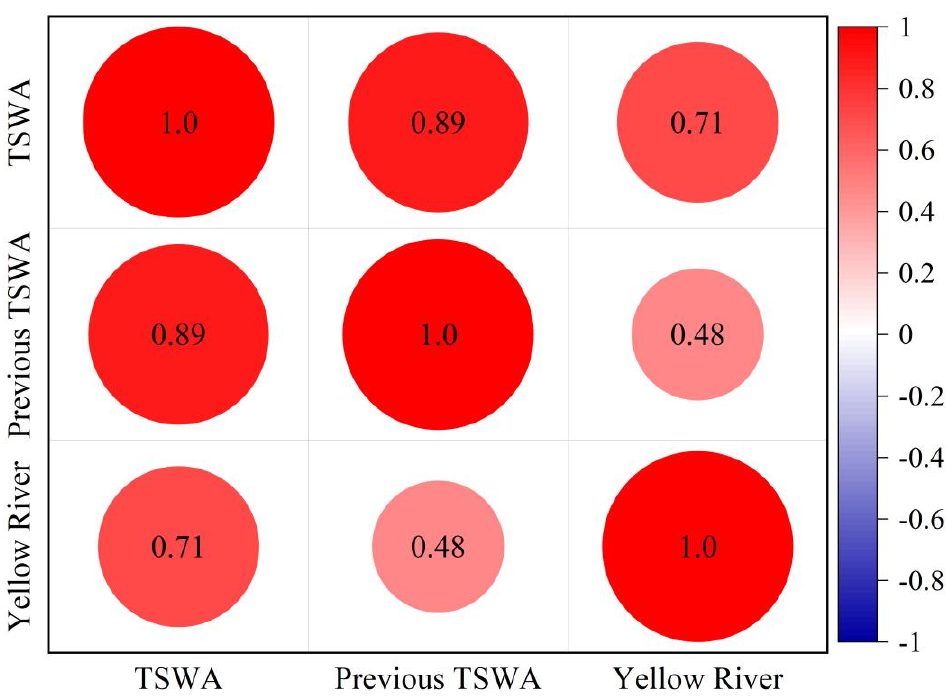
Figure 13. Correlation coefficient graph.